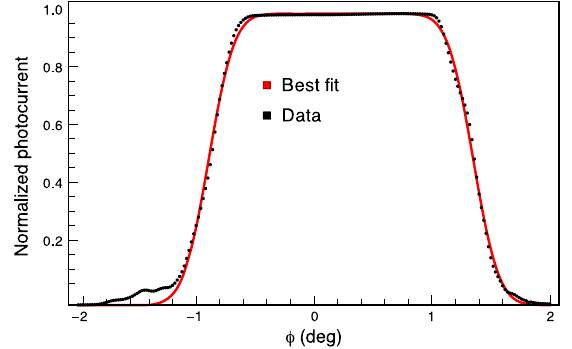
FIG. 17. Scan of detector response vs ϕ with no sample, using a 180 eV photon beam. The red curve is the best fit, using Eq. (19).